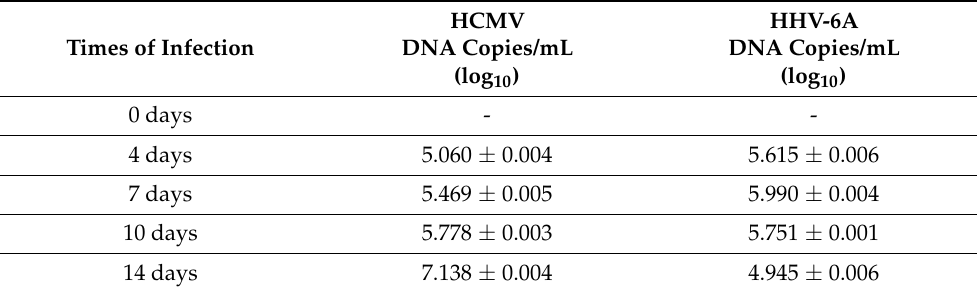
Table 1. Human cytomegalovirus (HCMV) and human herpesvirus 6A (HHV-6A) DNA amounts in infected primary human dermal fibroblasts at the indicated times p.i *. HHV-6A HCMV DNA Copies/mL Times of Infection DNA Copies/mL (log 10 ) (log 10 ) 0 days - - 4 days 5.060 ±